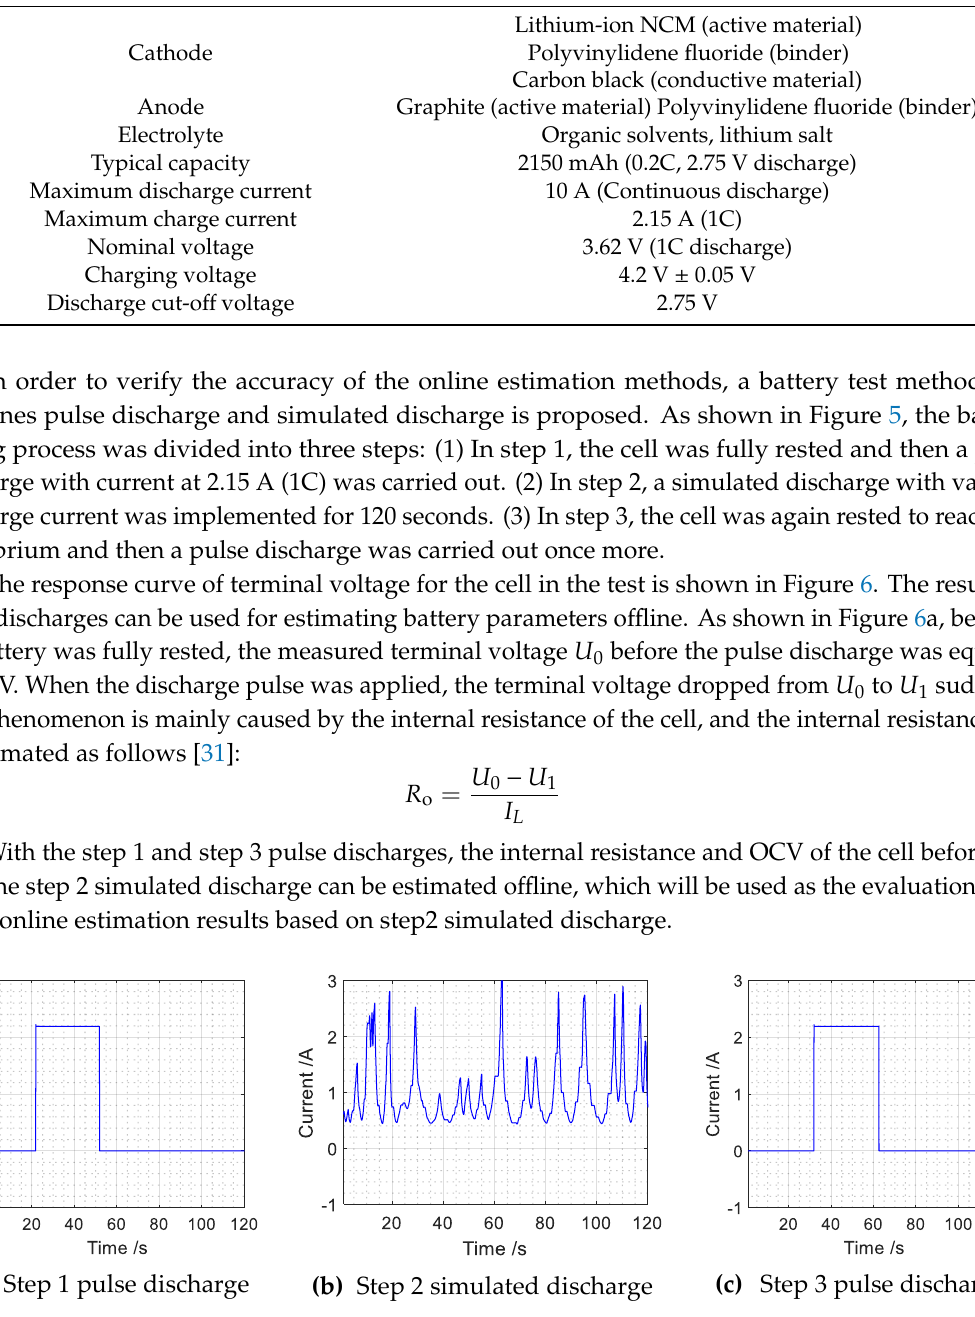
Figure 5. The self-defined outflow current curve of the cell being tested.